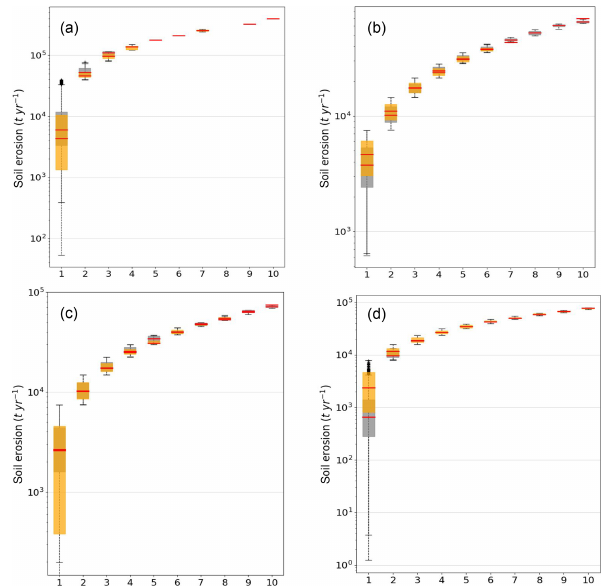
Figure 3. Quantile box-and-whisker plots of simulated gross soil erosion rates (tyr − 1 ) (gray box-and-whisker plots) compared to (a) the study by Cerdan et al. (2010), (b) the study by Panagos et al. (2015), and (c) the German potential erosion map by Bug et al. (2014) (orange box-and-whisker plots). (d) Quantile box-and- whisker plots of simulated net soil erosion rates (tyr − 1 ) (gray box- and-whisker plots) compared to the study by Borrelli et al. (2018) (orange box-and-whisker plots). Medians are plotted as red horizon- tal lines. The x axis represents bins or evenly spaced ranges between the minimum and maximum total yearly soil erosion rates of the Rhine derived from the data of (a) Cerdan et al. (2010), (b) Panagos et al. (2015), (c) Bug et al. (2014), and (d) Borrelli et al.